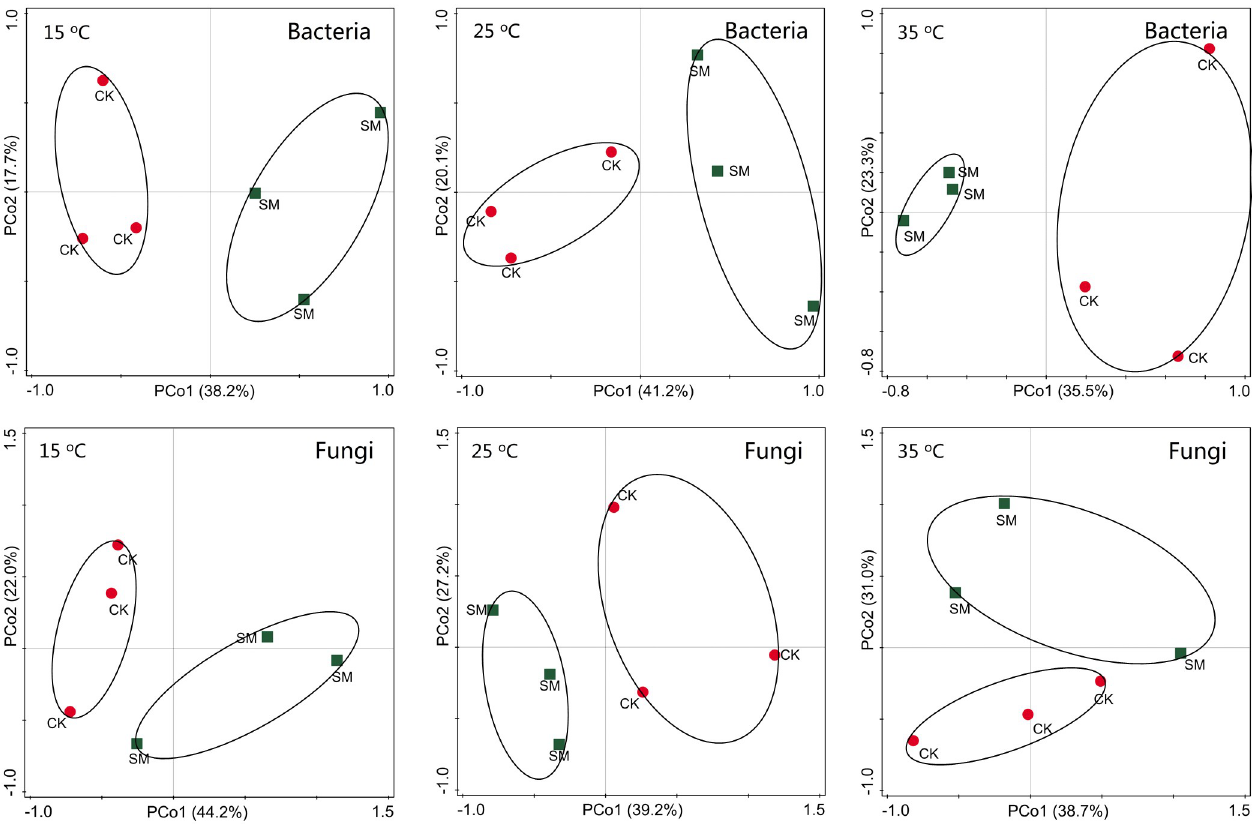
Fig 4. Principal Coordinates Analysis (PCoA) of soil microbial community composition under straw mulching and no mulching after incubation based on Bray-Curtis distances. CK: no mulching; SM: straw mulching.